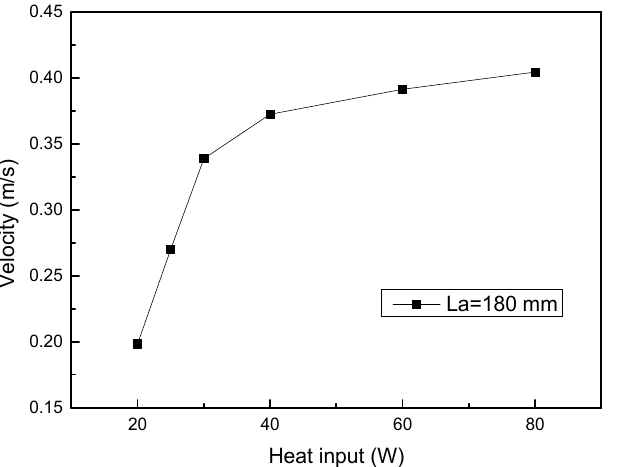
Figure 8. The mean velocity (absolute value) of the liquid slug PHP with the adiabatic section of 180 mm at a steady operation state.